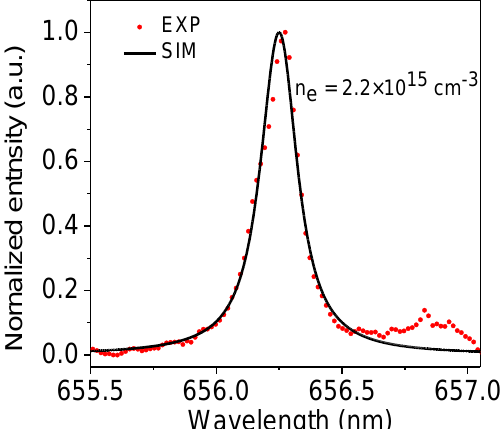
Figure 6. Comparison of the experimental H α line and simulated line. Table 2. Broadening of FEGLD plasma in H α .